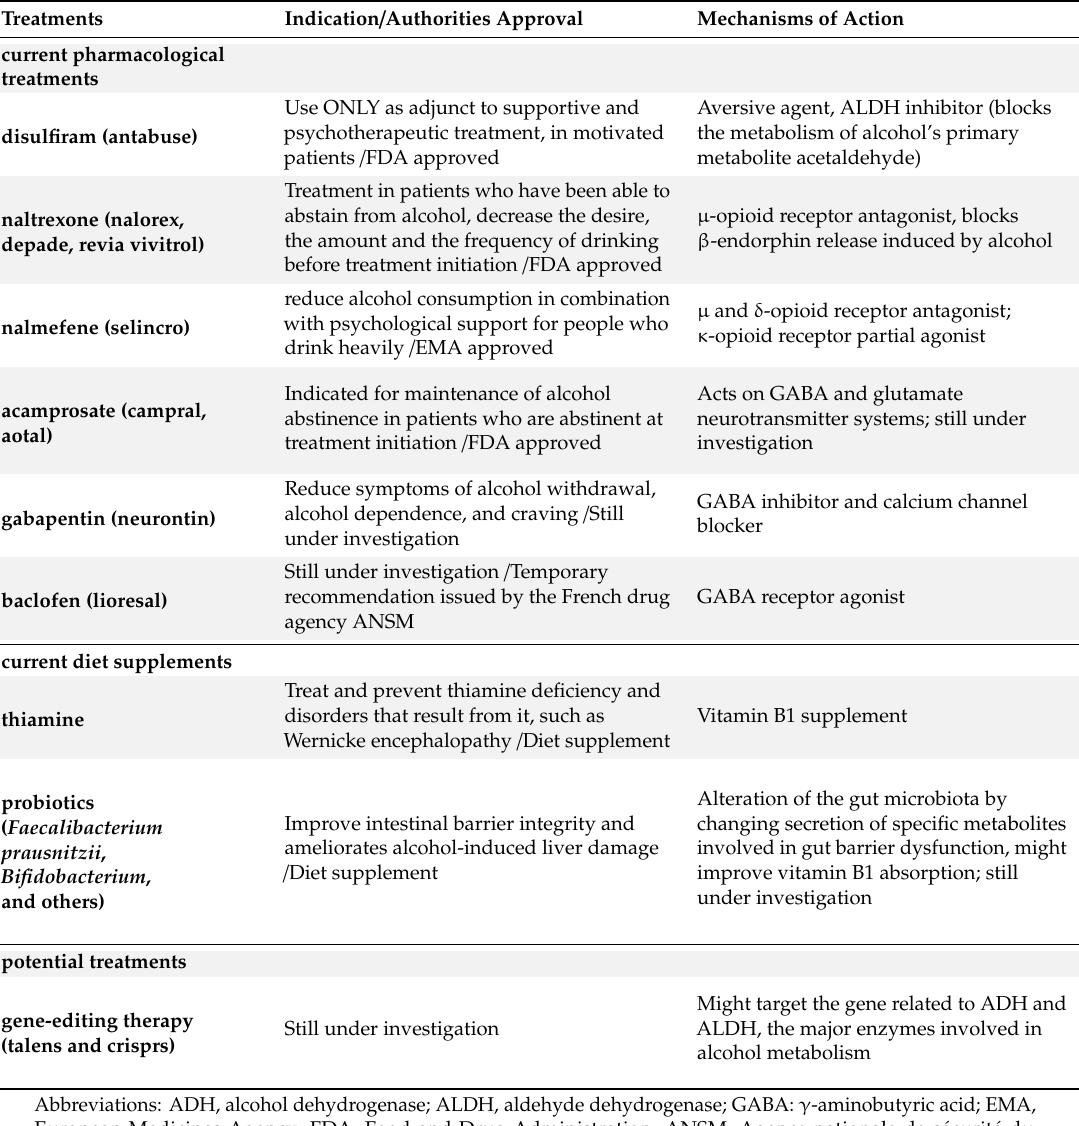
Table 1. Current and potential treatments for alcohol-related